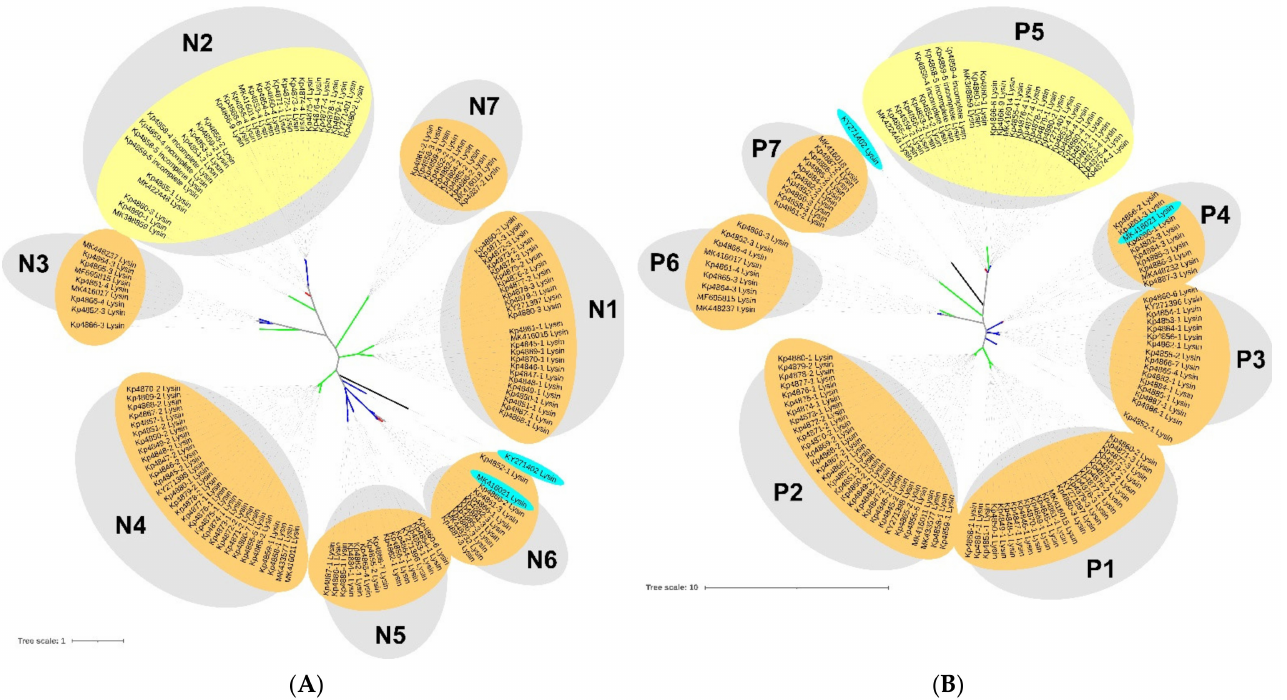
Figure 5. Phylogenetic trees of prophage endolysins based on ( A ) nucleotides and ( B ) amino acids sequences. Genomic tree was constructed using the Jukes–Cantor substitution model and the proteomic tree was constructed using the Le Gascuel substitution model in PHYML 3.3.20180621 (Geneious Prime version 2021.1.1). Trees were analysed and annotated using Interactive Tree Of Life (iTOL) v6 [51]. Tree branches represent Myoviridae (green); Siphoviridae (blue); Podoviridae (red); and Ackermannviridae (black) families (in silico determined). Grey-shaded circles represent clusters with identities higher than 50%. Small, shaded circles represent endolysins groups. Lysozymes/muramidases (orange); Chitinases (yellow); and Endopeptidases (light